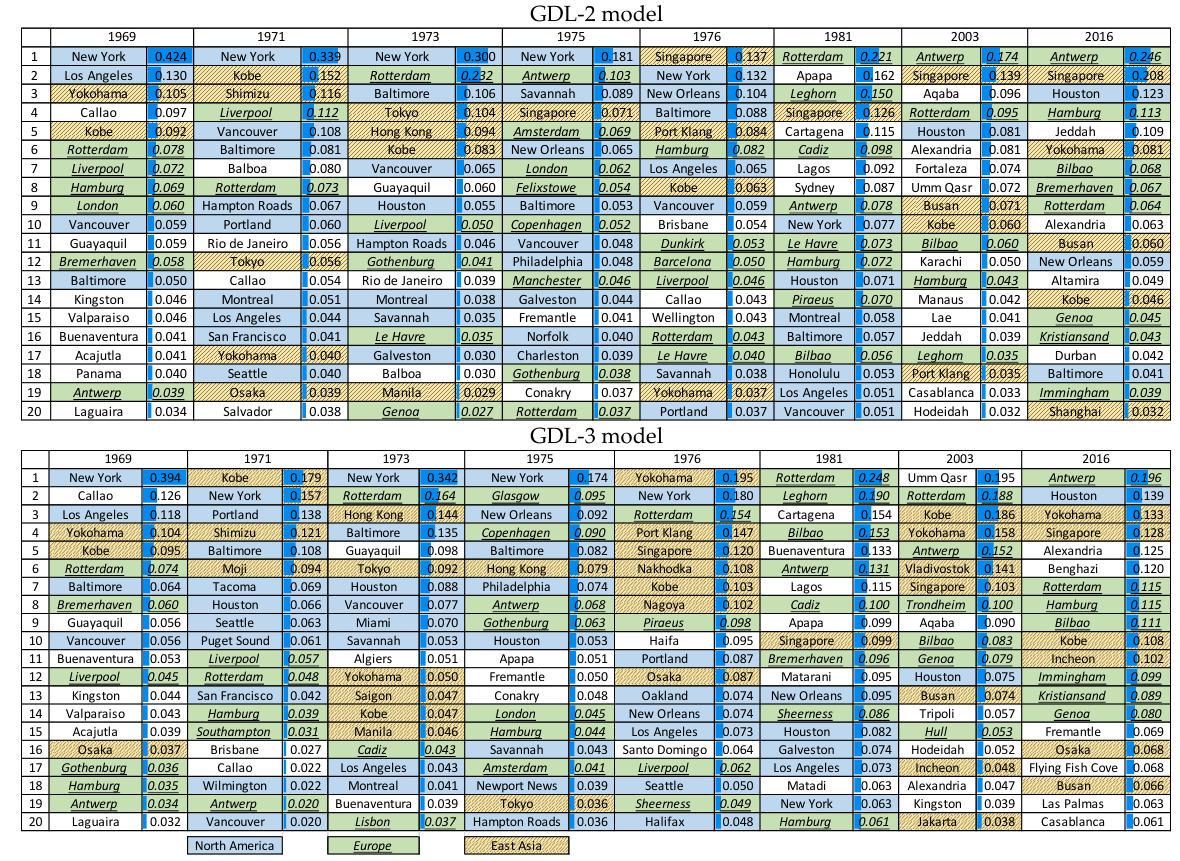
Figure 7. Top 20 ports in betweenness centrality and their scores estimated from the GDL-2 and GDL-3 models (1969–2016).